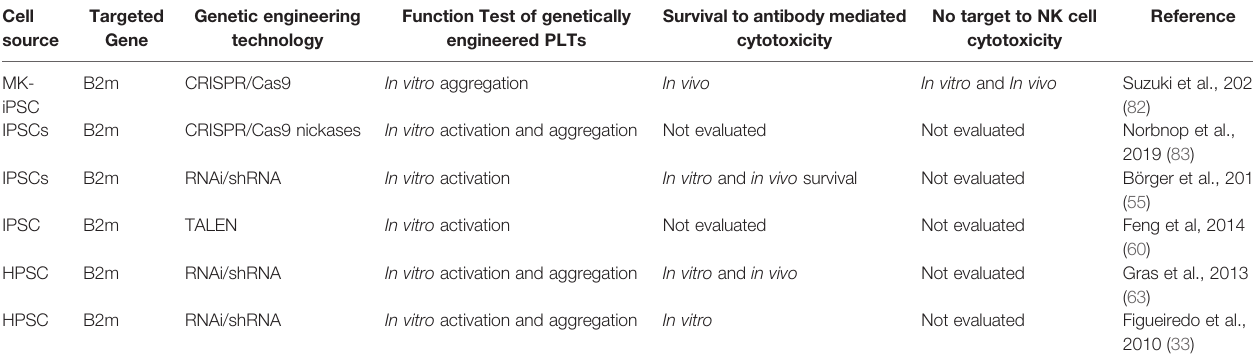
TABLE 2 | Impact of regulation of HLA expression on MKs and PLTs in functionality and survival to allogeneic immune responses. Cell Targeted source